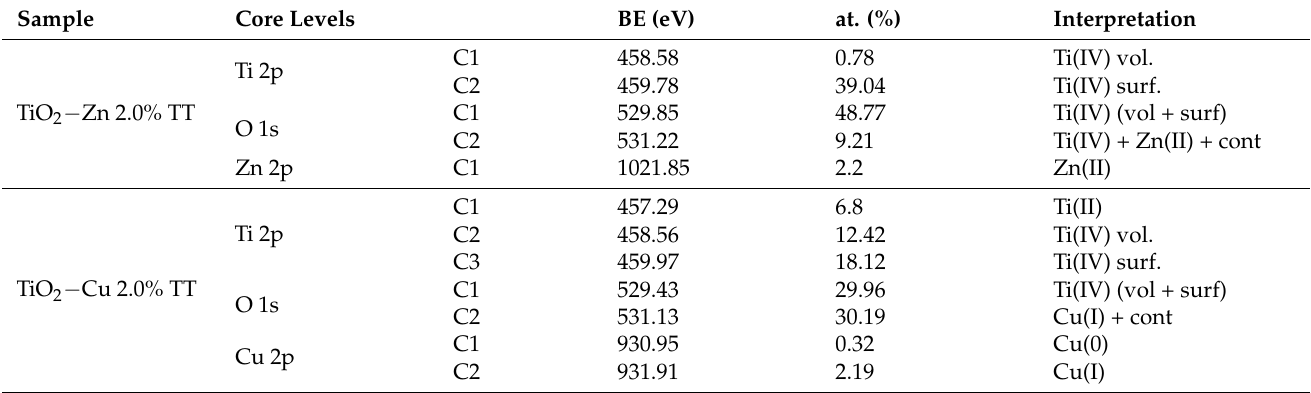
Table 5. Absorbance values for nanopowders in broth medium.